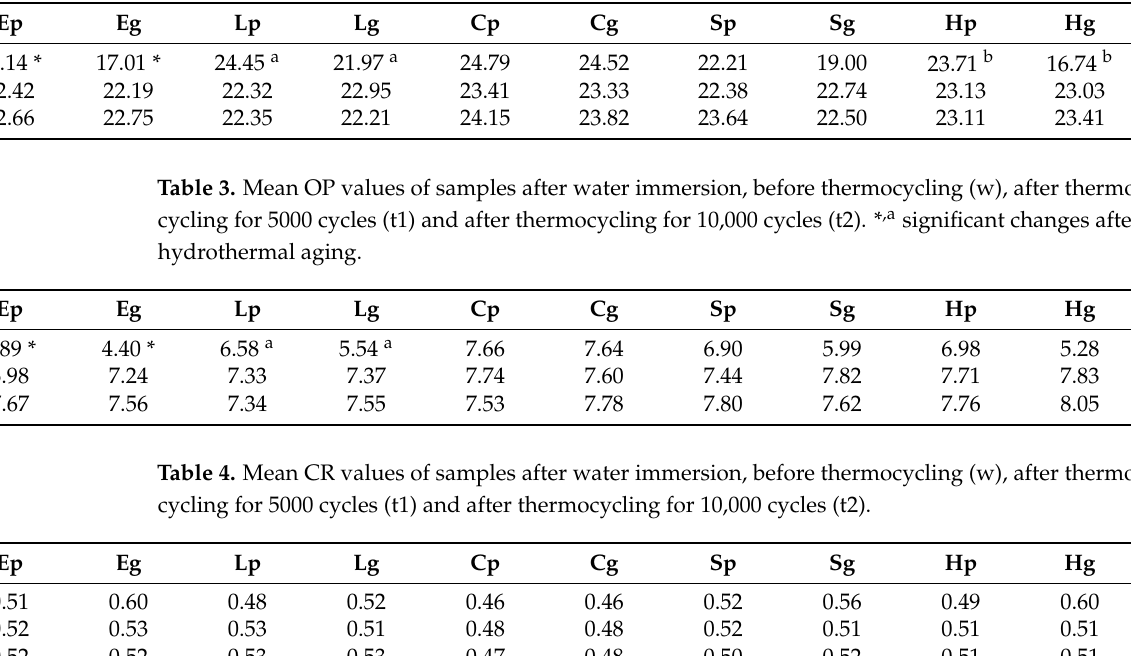
Table 2. Mean TP values of samples after water immersion, before thermocycling (w), after thermo- cycling for 5000 cycles (t1) and after thermocycling for 10,000 cycles (t2). * ,a,b significant changes after hydrothermal aging.